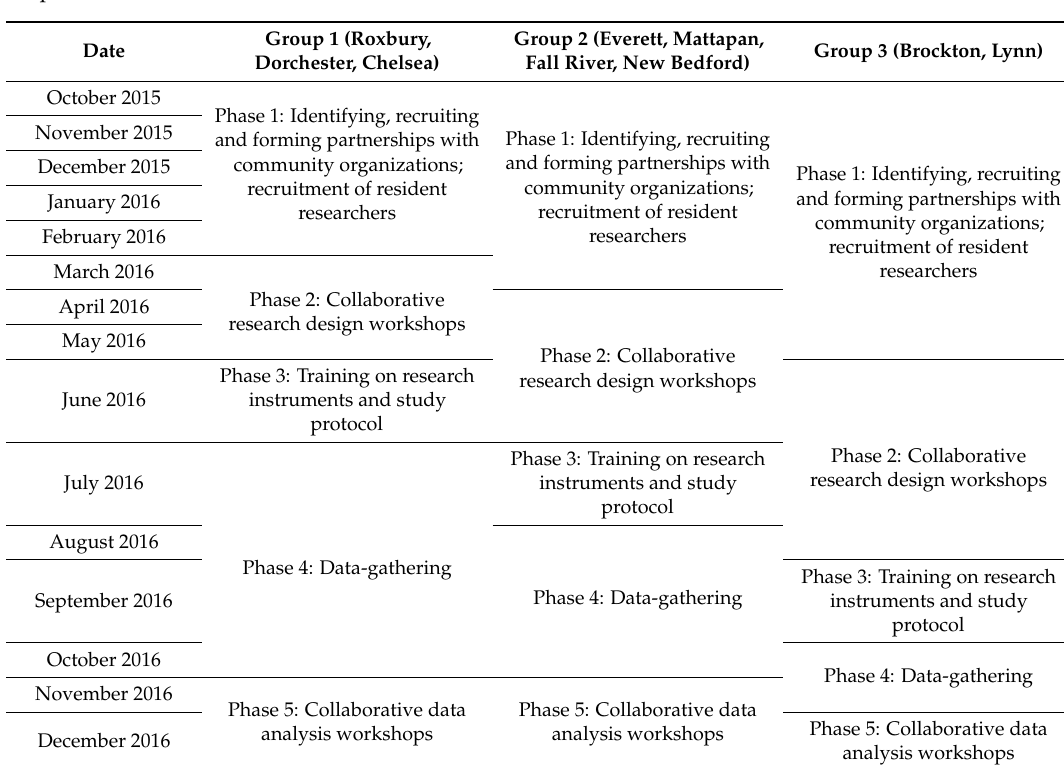
Table 1. The Healthy Neighborhoods Study (HNS) baseline participatory action research (PAR) process,